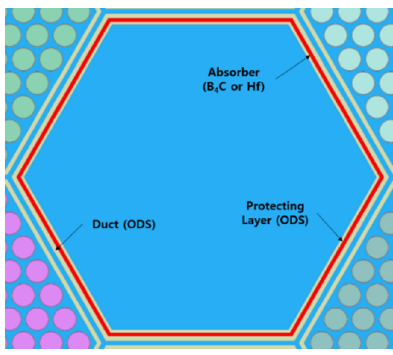
Figure 8. Concept of the replaceable fixed absorber (RFA) in the MMR.